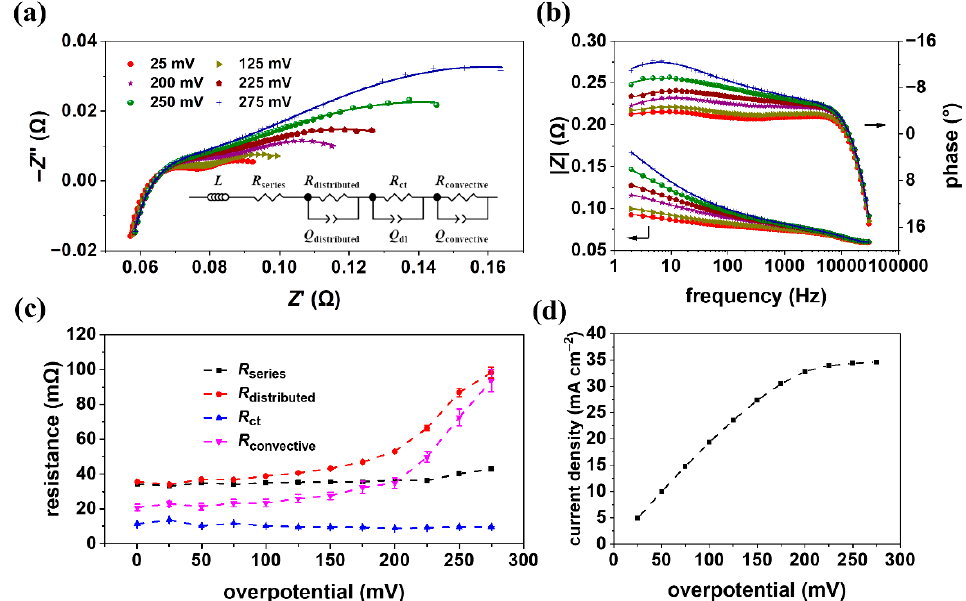
Figure 4. ( a ) Structural illustration of the porous electrode and schematic representation of electro ‐ chemical reaction that occurred at the interface in one pore; ( b ) Schematic illustration of the evolution of main electrochemical reaction zone with increasing overpotential in one pore.